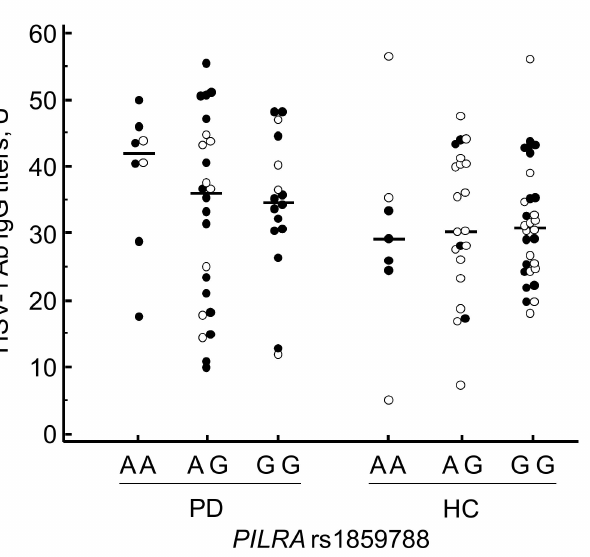
Figure 2. Distribution of serum HSV-1-specific IgG titers in Parkinson’s Disease patients and Healthy Controls according to PILRA rs2859788 genotypes and gender. Black dots: male; white dots: female. Horizontal lines represent the median. PD: Parkinson’s Disease; HC: Healthy Controls; U: